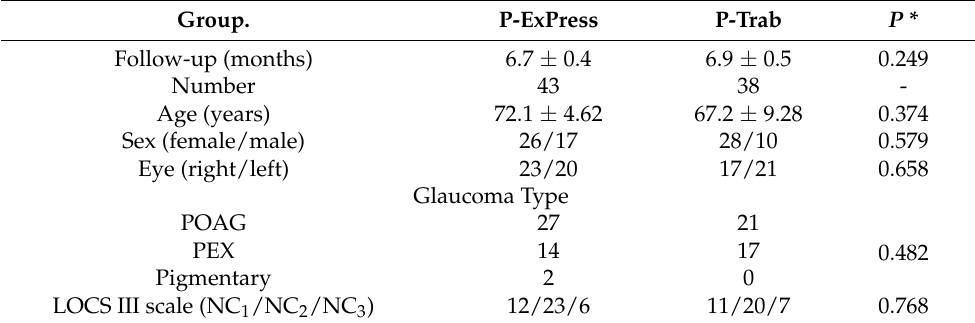
Table 1. Patient demographic data. Group.